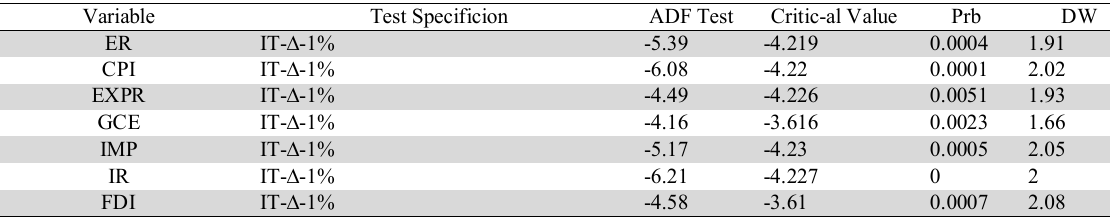
The results of ADF